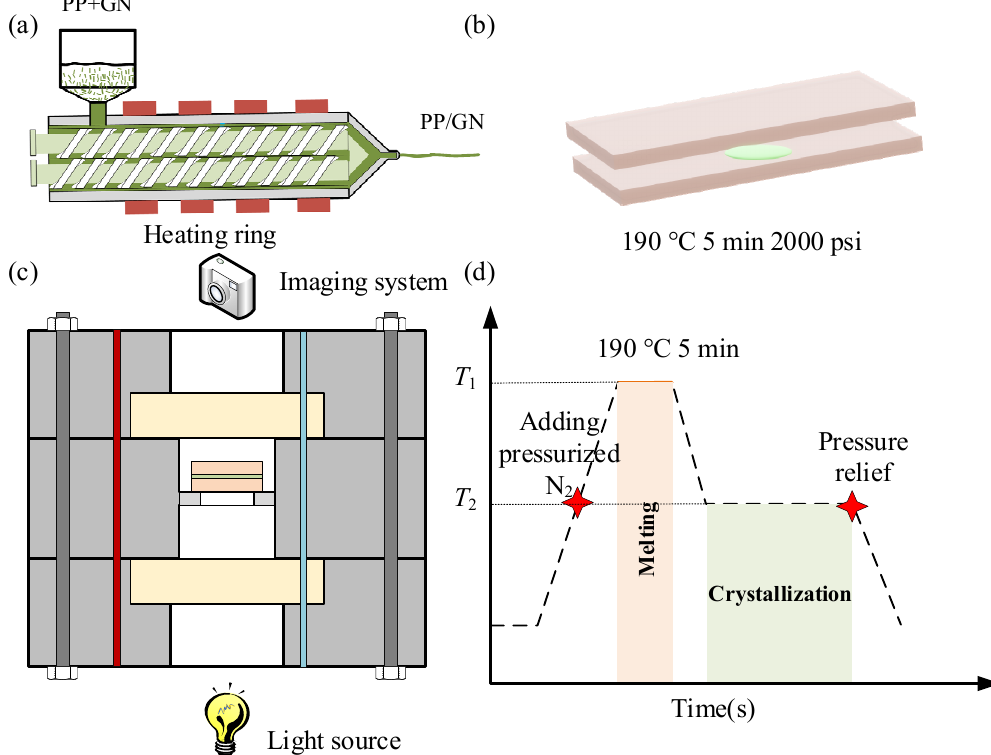
Figure 1. ( a ) Preparation of PP/GN nanocomposites based on twin-screw extruder, ( b ) fabrication of thin films, ( c ) the self developed in-situ visualization system, ( d ) N 2 and temperature diagram during isothermal crystallization.